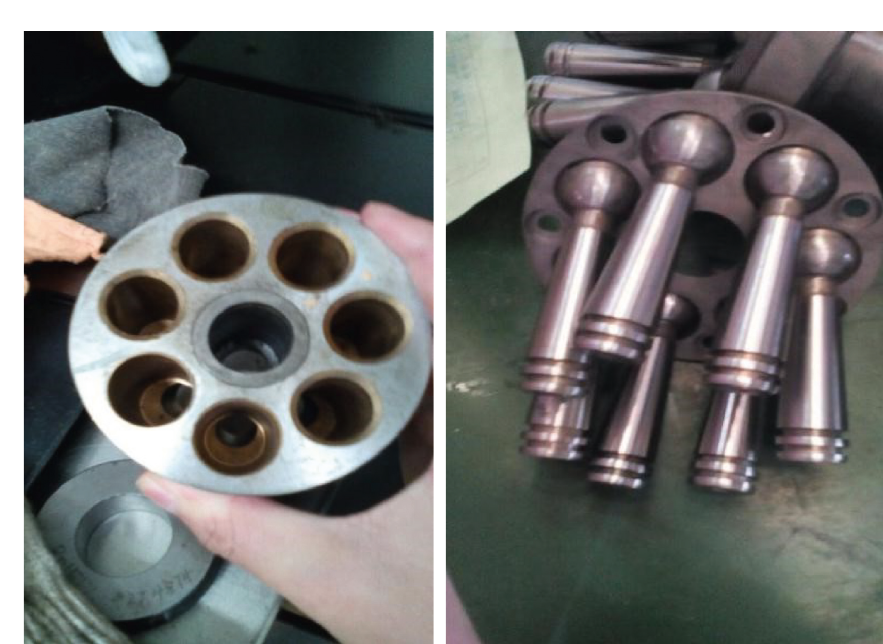
Figure 8: The plunger pair of Huade